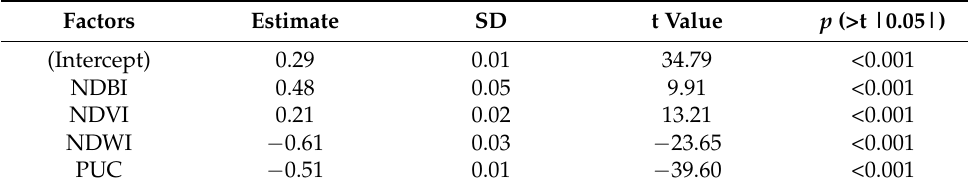
Table 3. Multiple Linear Regression